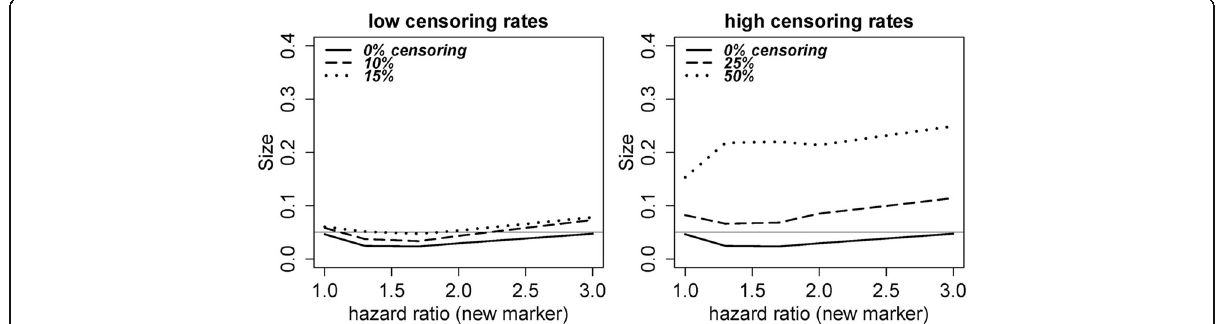
Fig. 1 Size of the original RC test (1) for low and high censoring rates. An uninformative new marker is added to a baseline model. Size is calculated as a fraction of significant RC